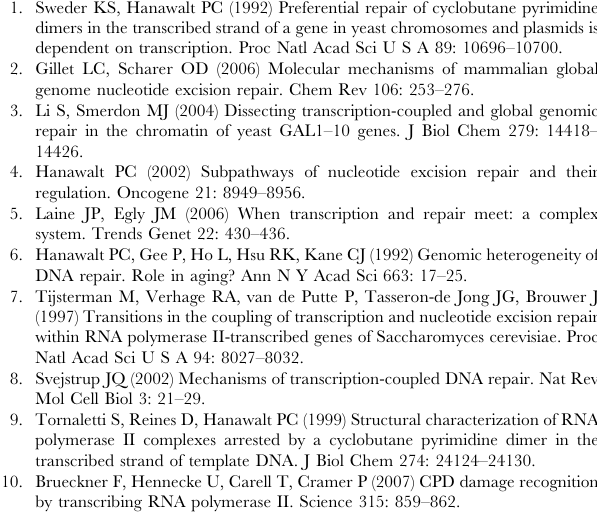
Figure S3 RNA polymerase II status during NER in different regions of the RPL2B locus. A. ChIP analysis of RNA polymerase II status during NER was done in three ORF regions of the RPL2B locus. B. Cells were irradiated with 100 J/ m 2 UV and incubated for different repair times as indicated.